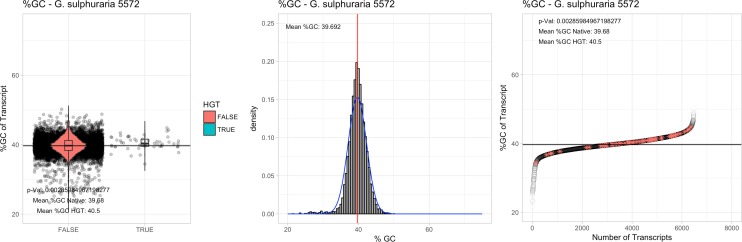
%GC – Galdieria sulphuraria 5572: (Left) Violin plot showing the %GC distribution across native transcripts and HGT candidates.(Mid) Cumulative %GC distribution of transcripts. Red line shows the average, blue line a normal distribution based on the average value. (Right) Ranking all transcripts based upon their %GC content. Red ‘*' demarks HGT candidates. As the %GC content was normally distributed, students test was applied for the determination of significant differences between the native gene and the HGT candidate subset.